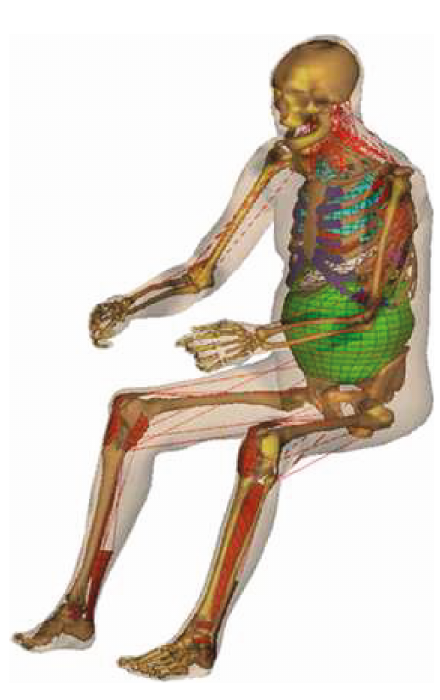
Figure 3: HUMOS model